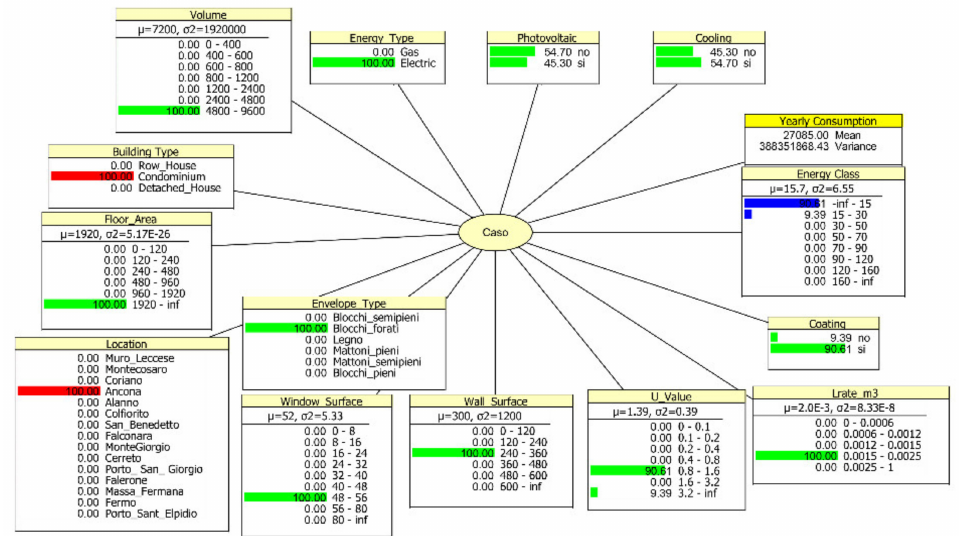
Figure 19. The effect of a PV installation in a case of a condominium located in the city of